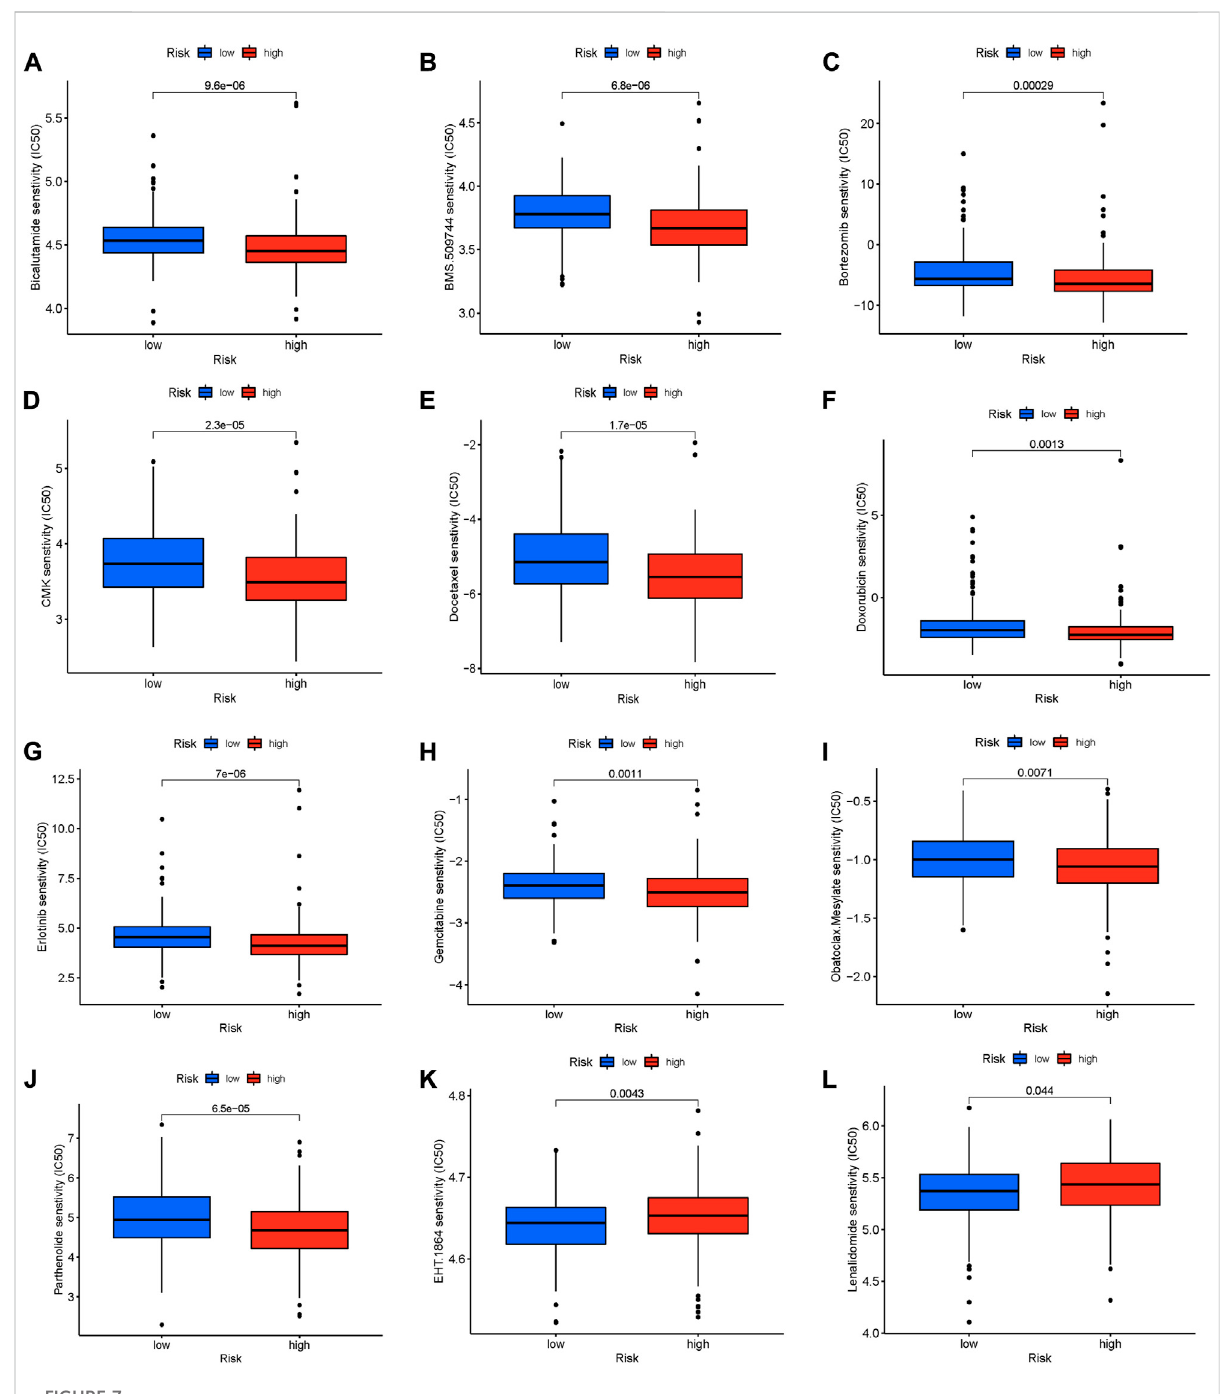
This just shows that risk score is closely related to the survival time of LUAD patients (Figure